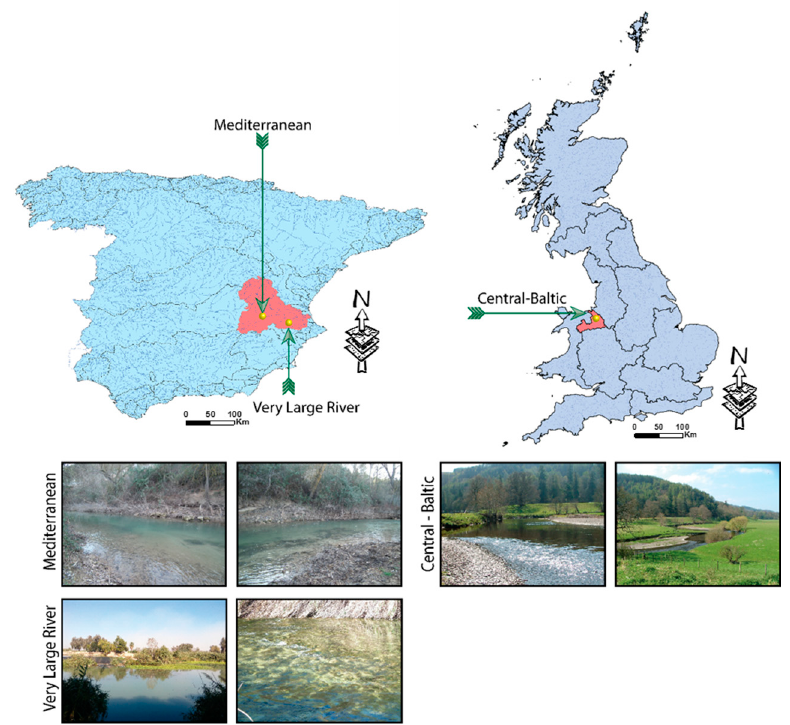
Figure 1. Schematic diagram showing the location of the selected study sites within each Geographical Intercalibration Group (GIG) and detailed imagery of the selected reaches. The maps of Spain and UK show the delineation of the main river basins with those basins containing the study sites highlighted in red. Table 1. Characteristics of the selected reaches within each of the Water Framework Directive Geographical Intercalibration Groups (GIGs). WFD D, WB ID, WB L, RL, RW and HMWB stand for Water Framework Directive Designation, Water Body Identification code, Water Body Length, Reach Length, mean wetted Reach Width and Heavily Modified Water Body, respectively. VLR stands for Very Large Rivers GIG. Area (m 2 ) refers to the total area within which hydromorphological features were identified. RW was estimated based on a total of 20 width measurements randomly taken along the reach. 1 [35] and 2 [33].